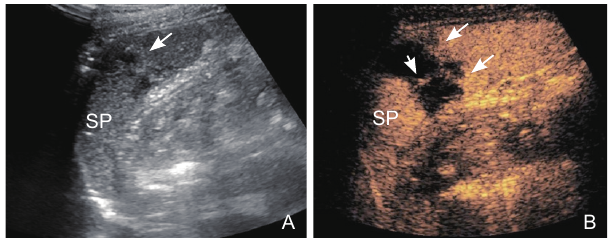
Figure 2 25-year-old female involved in a traffic accident. (A) Transverse oblique grey-scale US showed an injury site without clear boundaries in the middle of the spleen (arrow); (B) CEUS obtained from the same region showed the injury site in the middle of the spleen as an anechoic and hypoechoic perfusion defect (long arrows) with active bleeding (short arrow). SP, spleen. [Provided by Dr. Faqin Lv from Third Medical Center of Chinese PLA General